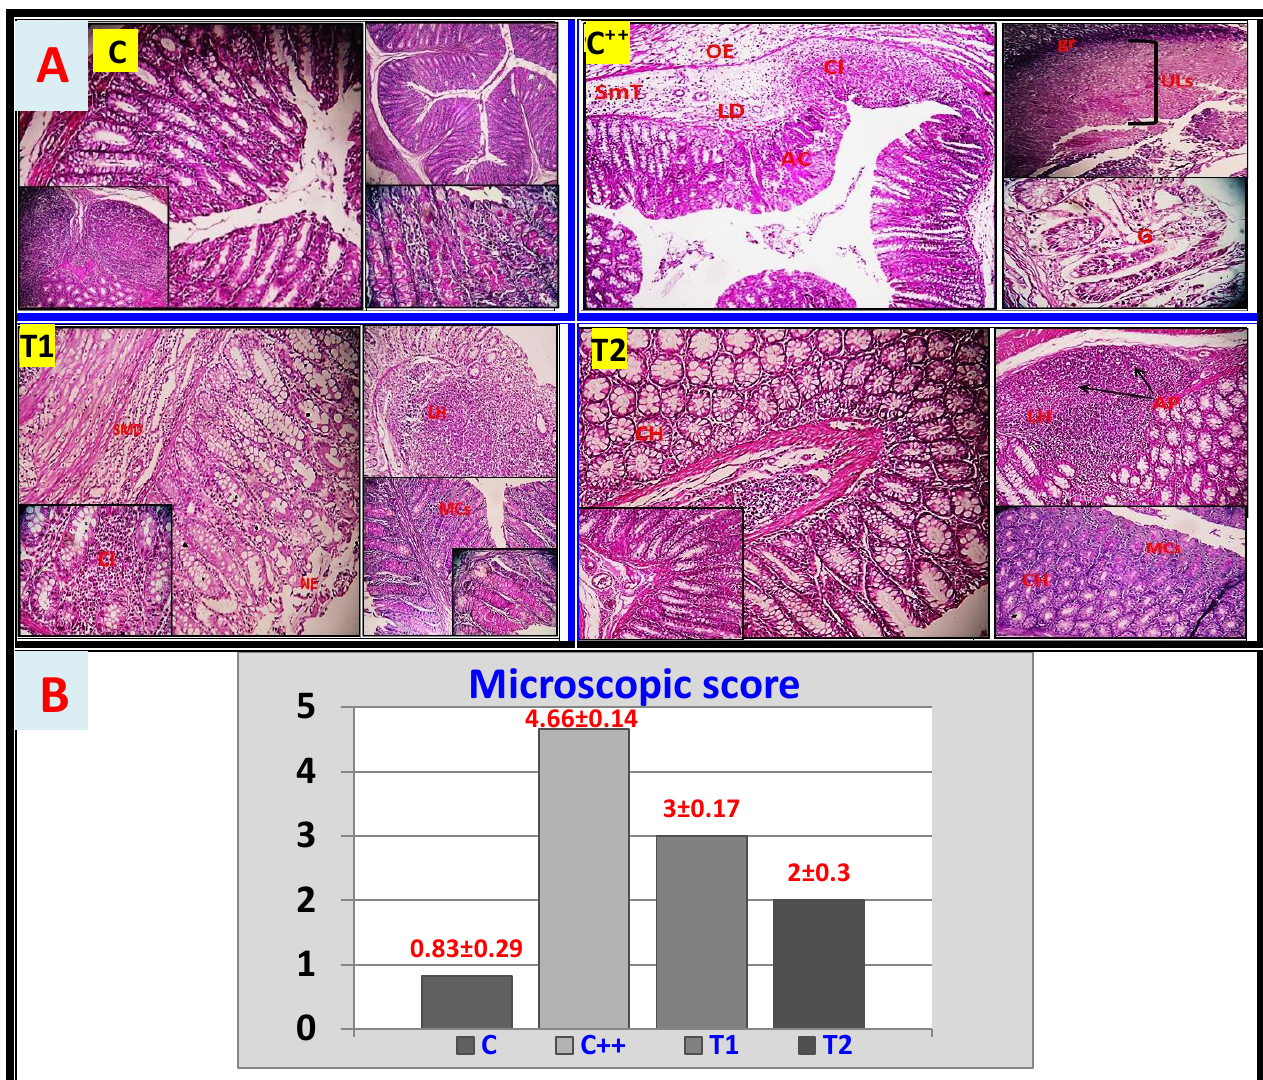
Figure 5. (A) Light microscopic images of colon sections. (B) Colon microscopic score represents th gross lesion protective role of synbiotic against E. coli infection. N=4. Mean±SE. (NE) necrotic, (LD) lymphoid depletion, (AC) Atrophy of crypt, (OE) odema, SmT) sub mucosal tissue, (CI) Cellular infiltration, (CH) hyperactivity of crypts, (G) gland in colon, (ULs) Ulcer layers, (gr) granulation layer, (MCs) hyperplasia of mucus cells, (SMD) Sub mucosal diffusion, (LH) Lymphoid tissue hyperplasia, (AP) Apoptosis. (Pas and H&E) 400X, 100X, and 200X. C: control negative group. C++: control positive group. T1: Fenugreek administered to enteritis group. T2: Fenugreek and L.